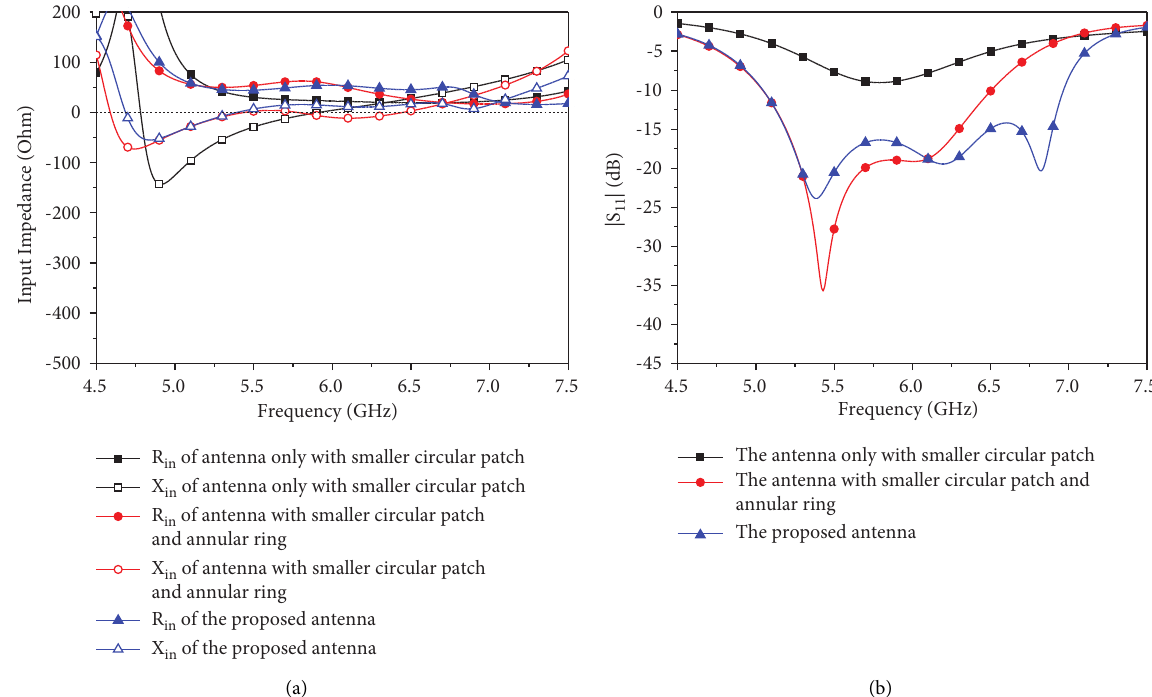
Figure 2: Simulated input impedance and | S 11 | without and with annular ring and shorting vias. (a) Input impedance. (b) | S 11